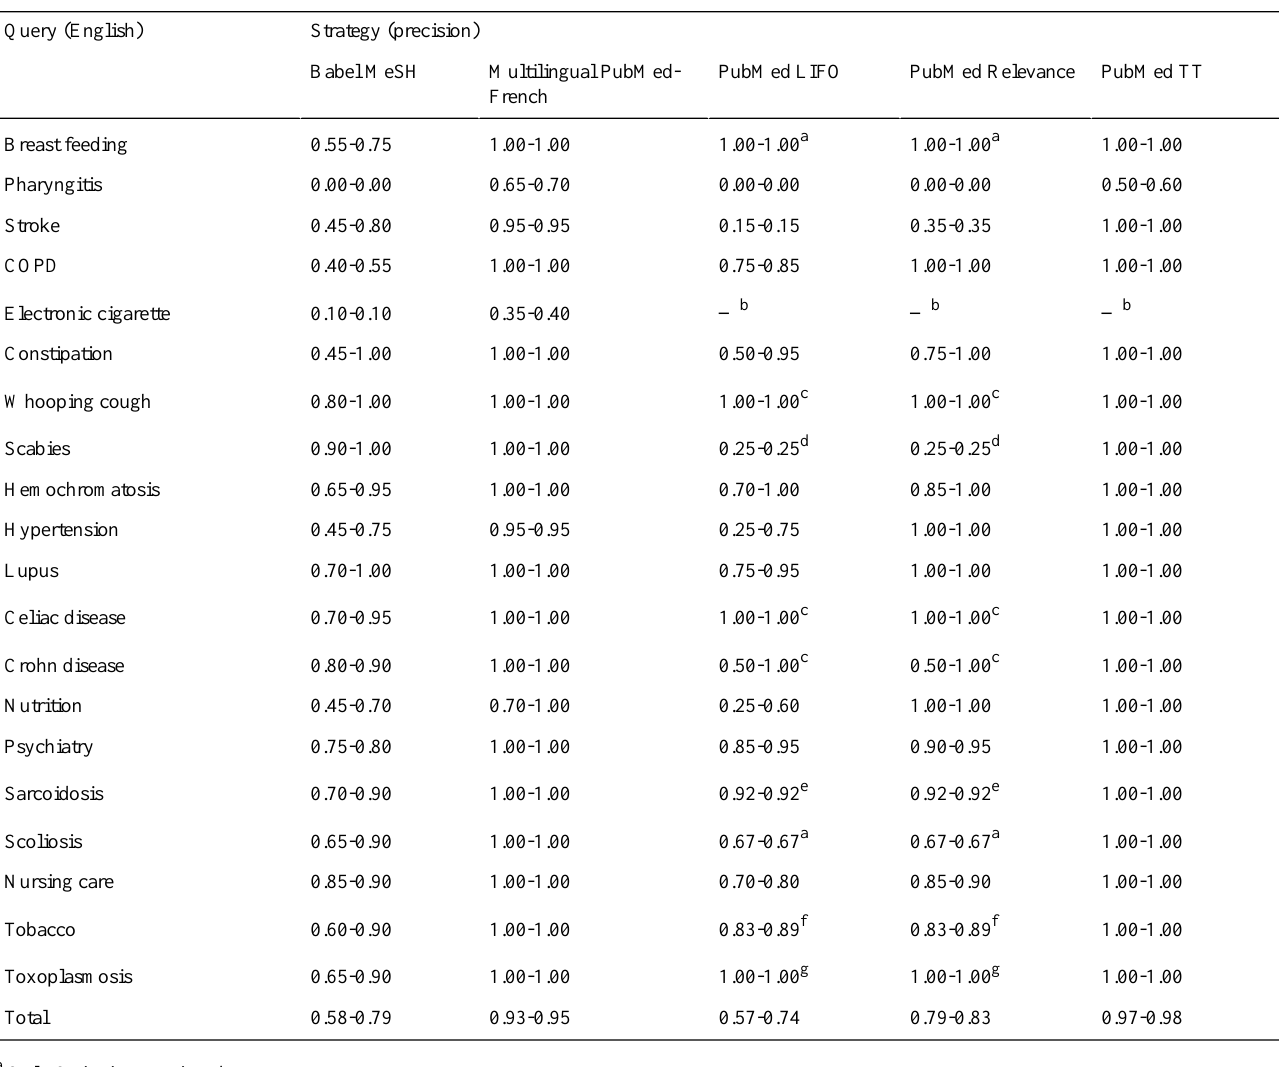
Table 5. Precision measured on the first 20 citations for each query for each strategy (analysis-relaxed analysis). Strategy (precision)Query